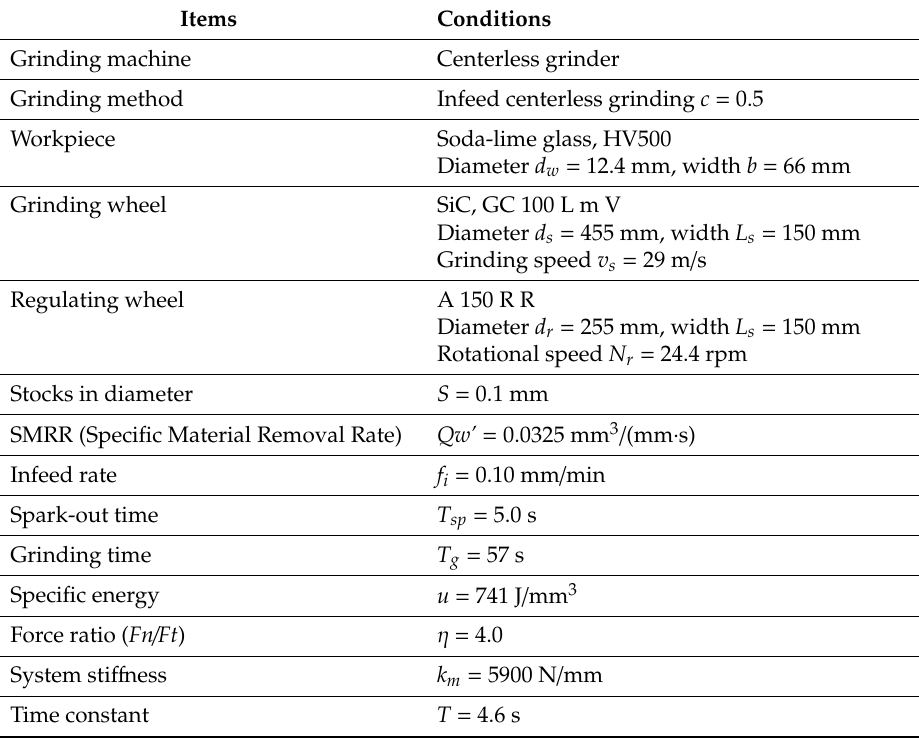
Table 2. Experimental setup in infeed centerless grinding.